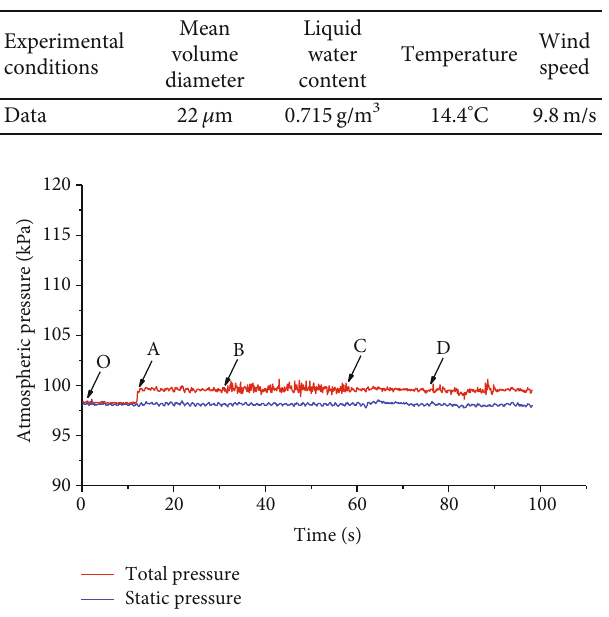
Figure 11: Total and static pressure outputs when the pitot tube is at normal temperature and the spray system is open. O – A: the entire air pressure detection system is stationary. A – B: the L- shaped pitot tube is placed into the ice wind tunnel at point A, and the total pressure hole is facing the incoming wind direction. B – C: the spray system is opened at point B to allow the water droplets to hit the pitot tube evenly. C – D: the spray system is closed at point C. After point D, the spray system is reopened.